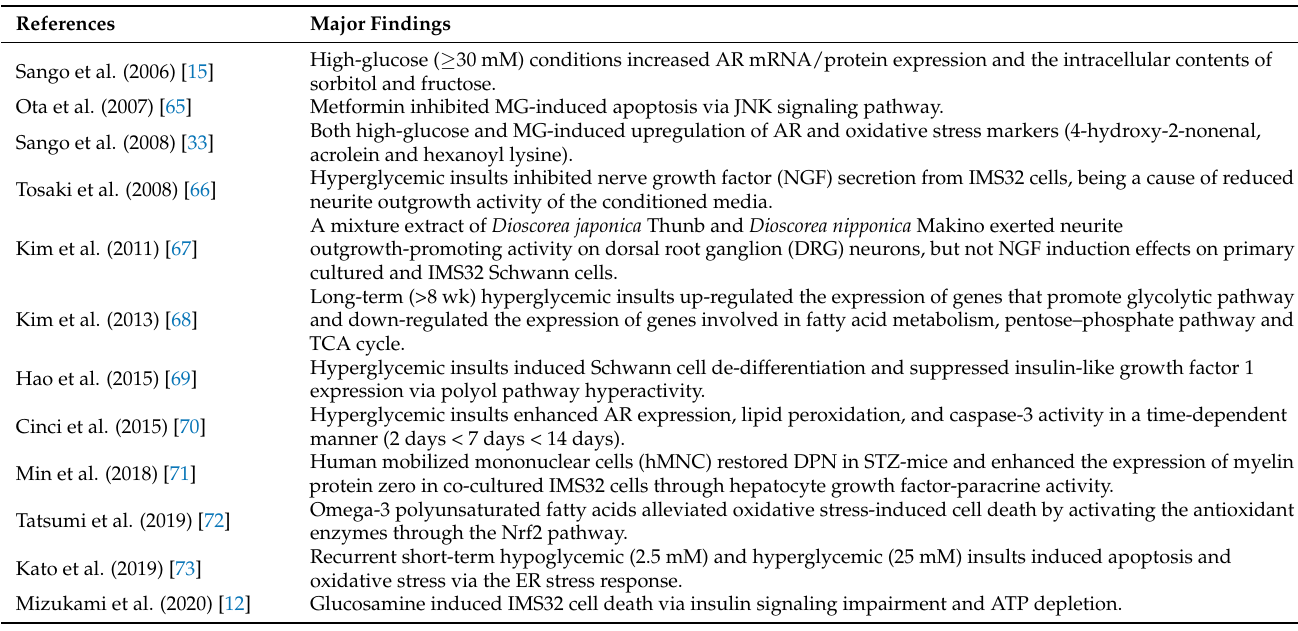
Figure 3. IMS32 cells showed distinct Schwann cell phenotypes such as spindle-shaped morphology under a phase-contrast microscope ( a ) and immunoreactivity to p75 low-affinity neurotrophin receptor (p75 NTR ) ( b ). Modified from Sango et al., Experimental Diabetes Research 374943 (2011) [16] (The publisher grants us the right to reuse the figure in other publications). Table 2. IMS32 Schwann cells utilized for the study of diabetic peripheral neuropathy (review articles are not included).